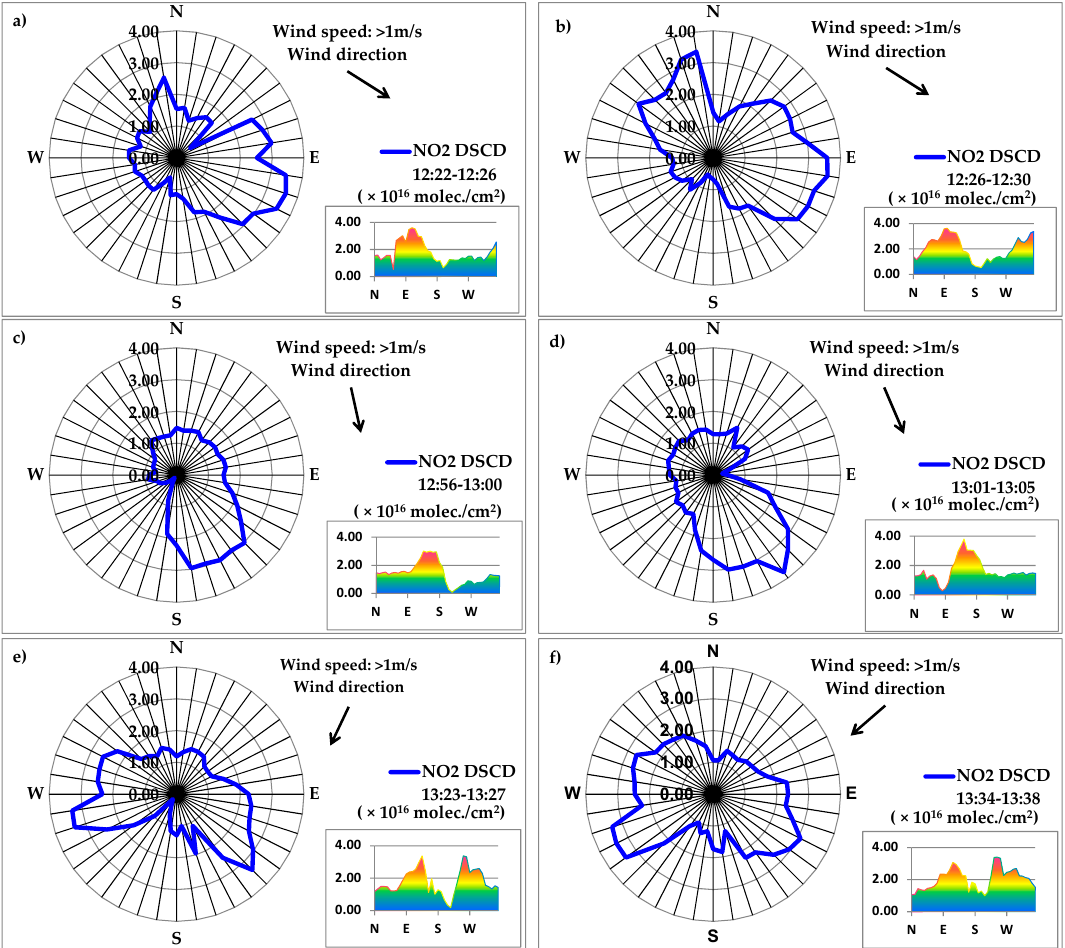
Figure 9. ( a – f ) The NO 2 DSCD (blue line from radar type figures) obtained from the full azimuthal scans using UGAL-2D-DOAS system performed on 21 June 2017 for the following local time periods: ( a )12:22–12:26; ( b )12:26–12:30; ( c )12: 56–13:00; ( d )13:01–13:05 ( e )13:23–13:27; ( f ) 13:34–13:38.